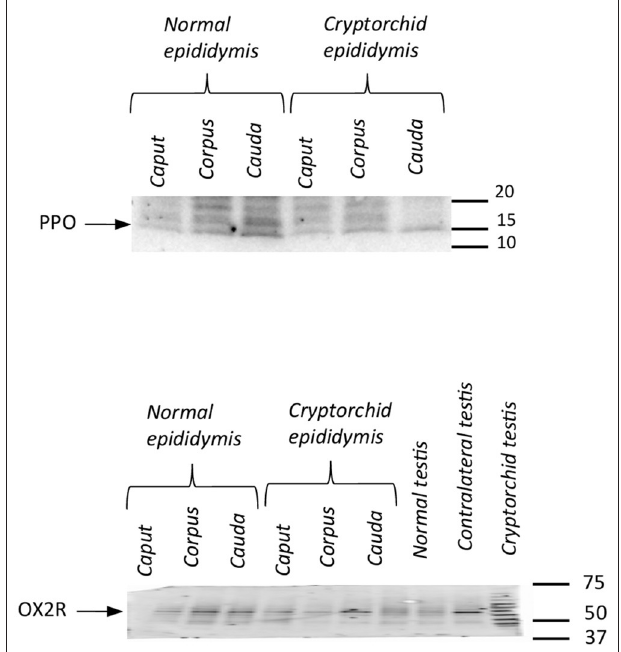
FIGURE 4 | Western blotting of PPO and OX2R in normal and cryptorchid dogs. Representative Western blot detection of OX2R (A) and PPO (B) in dog tissues. Data are representative of three independent